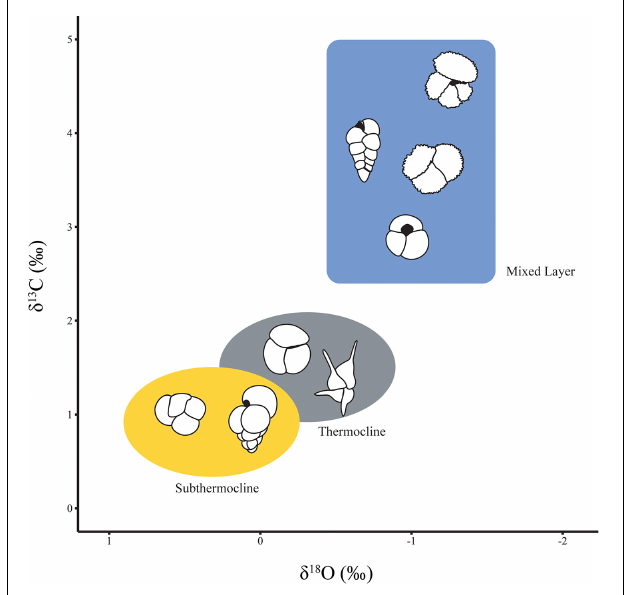
FIGURE 1 | Schematic figure showing the three main eco groups as defined in Aze et al. (2011) based on stable isotope measurements. This figure is illustrative and does not represent absolute values for each ecogroup. Top to bottom the mixed layer is represented by schematic outlines of Acaranina spp. , Chiloguembelina spp ., Morozovelloides spp. and Globigerinatheka spp. Left to right the thermocline is represented by Subbotina spp. and Hantkenina spp. and the subthermocline represented by Catapsydrax spp. and Jenkinsina spp. Note the reversed scale on the x -axis. Modified from Pearson